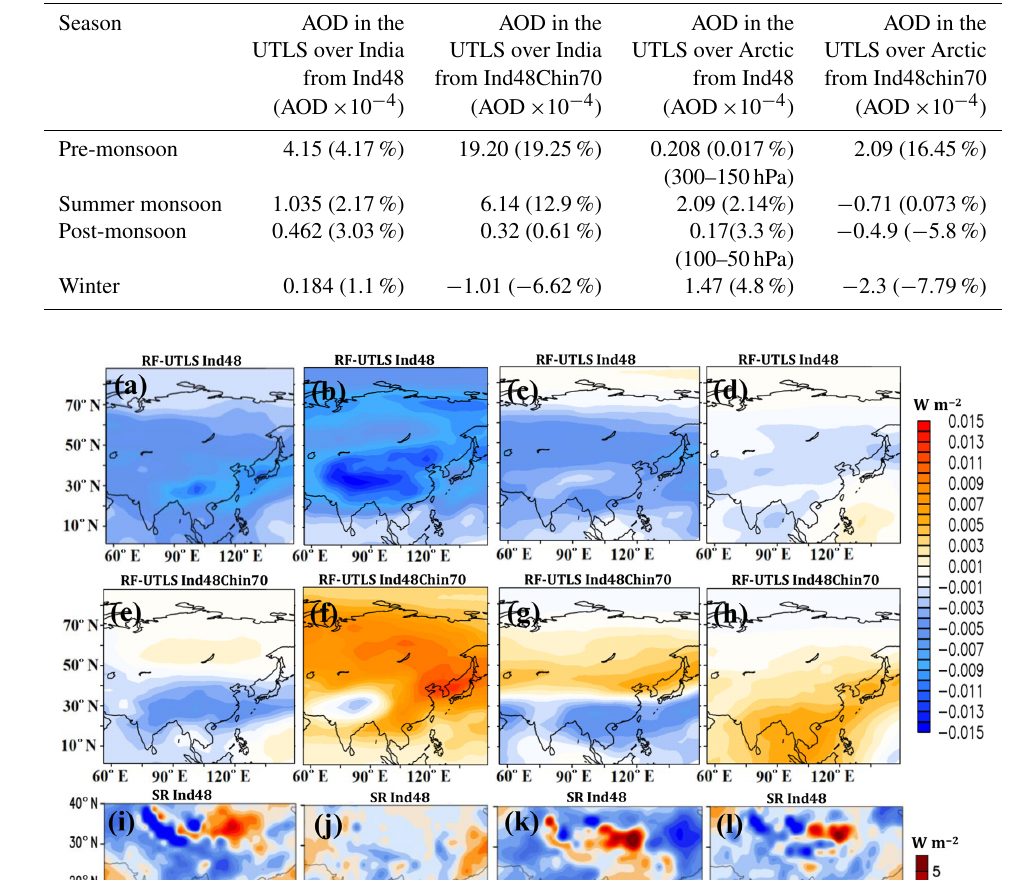
Table 2. Seasonal mean AOD in the UTLS (300–90hPa) over India (20–35 ◦ N, 75–95 ◦ E) and the Arctic (65–85 ◦ N, 75–97 ◦ E) from simu- lations performed. AOD is calculated at different altitude ranges indicated in brackets for some seasons since the sulfate aerosol layer varies in altitude in the UTLS.